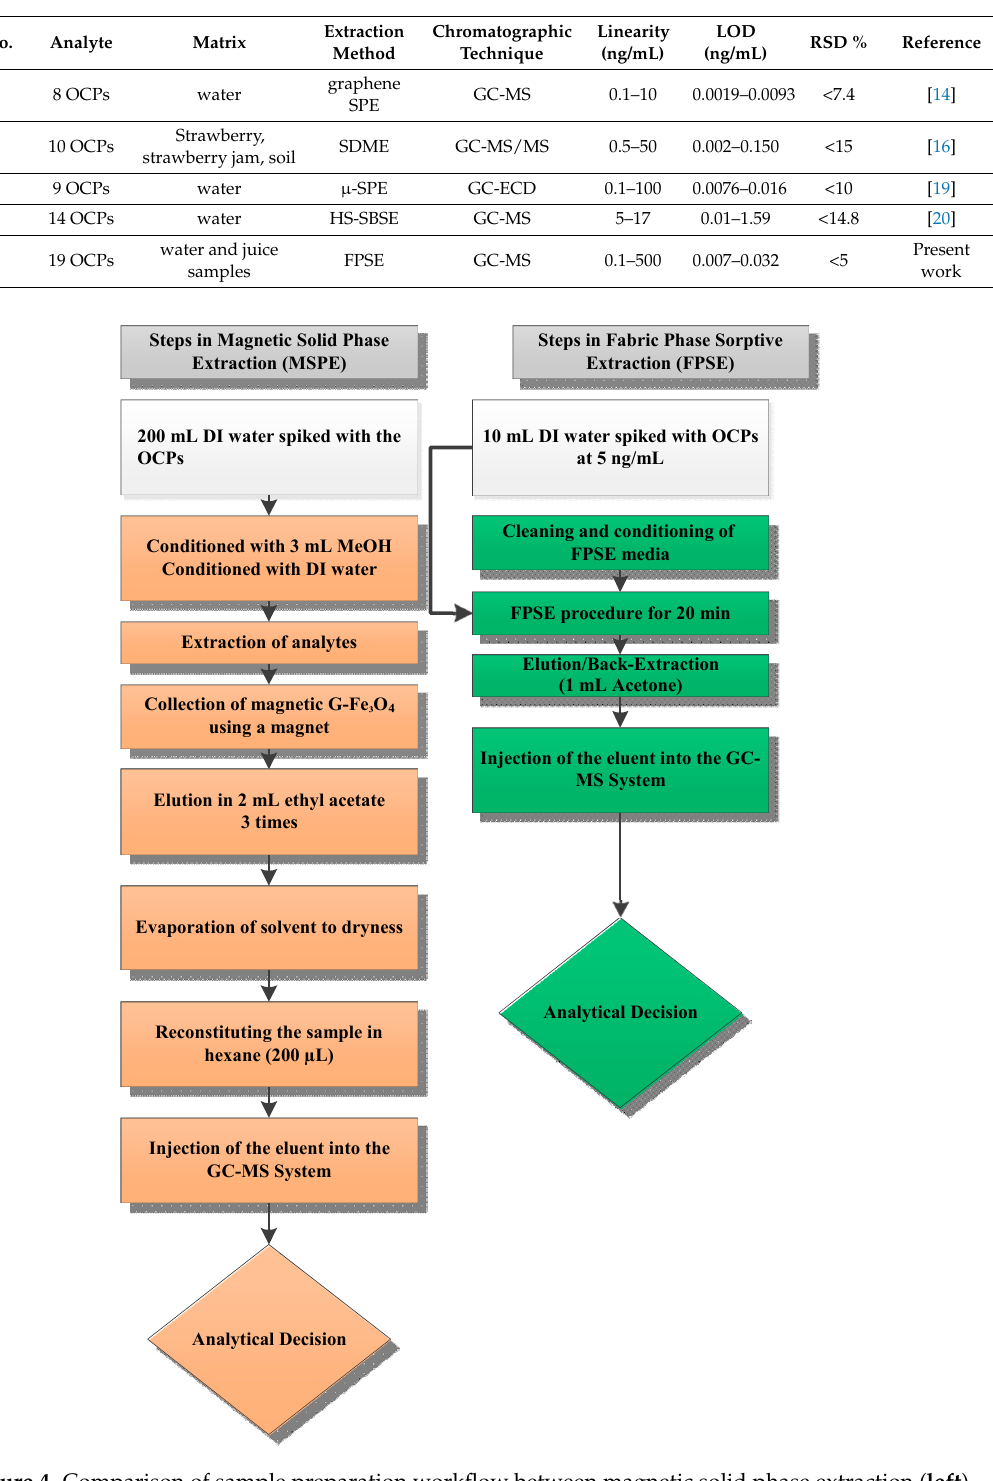
Figure 4. Comparison of sample preparation workflow between magnetic solid phase extraction ( left ) and fabric phase sorptive extraction ( right ).